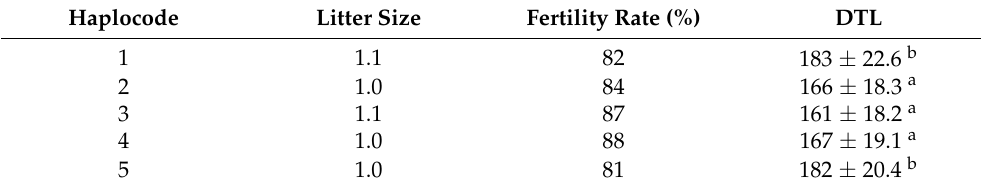
Table 4. Litter size, fertility rate, and DTL according to haplotypes. Data are expressed as LSmeans.